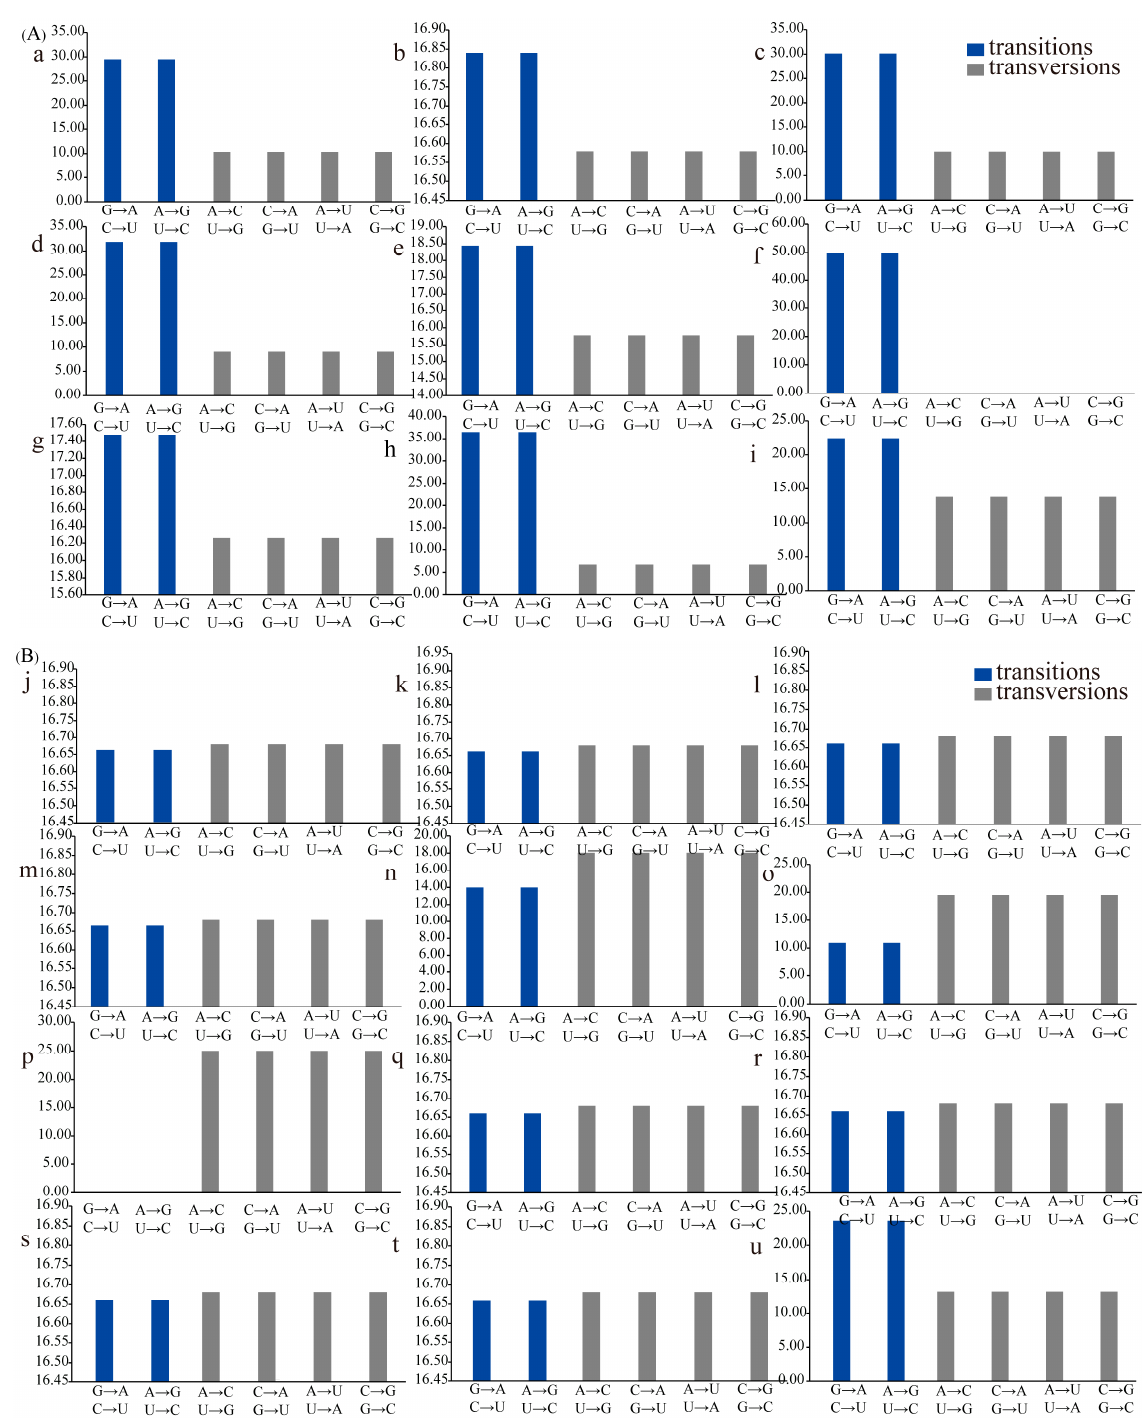
11 of 18 Figure 5. Phylogenetic tree of chloroplast tRNAs. A, alanine (Ala); R, arginine (Arg); N, asparagine (Asn); D, aspartate (Asp); C, cysteine (Cys); Q, glutamine (Gln); E, glutamate (Glu); G, glycine (Gly); H, histidine (His); I, isoleucine (Ile); L, leucine (Leu); K, lysine (Lys); M, methionine (Met); F, phenylalanine (Phe); P, proline (Pro); S, serine (Ser); T, threonine (Thr); W, tryptophan (Trp); Y, tyrosine (Tyr); V, valine (Val). The green solid circle represents Gossypium ; the red solid triangle represents P. taeda ; the pink solid diamond represents A. lyrate ; the yellow solid triangle represents P. nudum ; the orange solid triangle represents D. hirsuta ; and the blue solid square represents Nostoc sp. PCC 7524. Phylogenetic analysis showed the polyphyletic origin of chloroplast tRNAs. 3.6. Transition/Transversion of tRNAs tRNAs have evolved with almost equal transition and transversion rates in spite of the small probability of transition or transversion events in tRNAs. In the present study, we found some intriguing phenomena in the substitution rate of cotton chloroplast tRNAs. A transition rate of 16.66 and transversion rate of 16.68 were found in tRNA Ala , tRNA Phe , tRNA Asp , tRNA Pro , tRNA Tyr , tRNA Val , and tRNA Ile . This showed that the trans- version rate was slightly higher than the transition rate, and these tRNAs evolved with almost the same transition and transversion rates (Figure 6, Table S4). The highest tran- sition rate was 50.00 for tRNA Trp and the highest transversion rate was 25.00 for tRNA His . Correspondingly, the lowest transition rate (0.00) was observed for tRNA His , and the lowest transversion rate (0.00) for tRNA Trp (Figure 6). This indicated that the tRNA Trp of the cotton cp genome had experienced a high transition rate without any transversion.